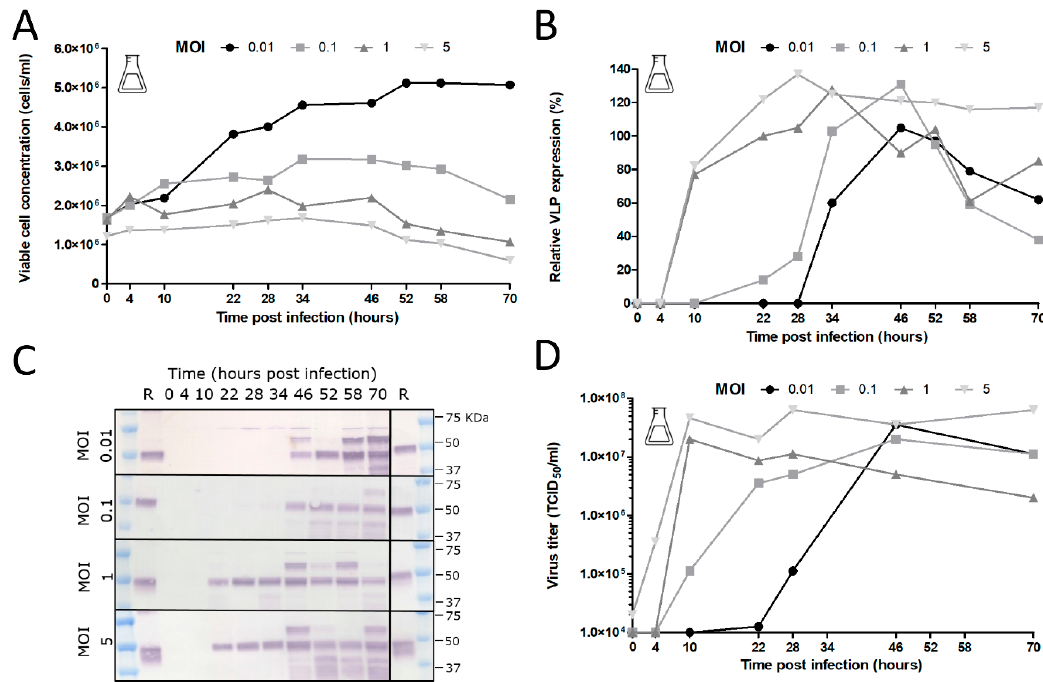
Figure 7. Effect of multiplicity of infection (MOI) on cell growth, baculovirus production and chikungunya VLP expression. ( A ) Cell growth after BACe56-CHIKV infection of Sf9 cells in shake flasks. Baculovirus infection was performed at different MOIs ranging from 0.01 to 5 TCID 50 /cell. ( B ) Baculovirus titers upon BACe56-CHIKV infection as function of MOI. Viral titers were determined by end point dilution assay and are expressed as tissue culture infective dose 50% per ml (TCID50 / mL). ( C ) CHIKV VLP expression determined by Western blot detection with anti-E2 polyclonal antiserum. R; reference VLPs ( D ) Relative CHIKV VLP expression levels as function of MOI.